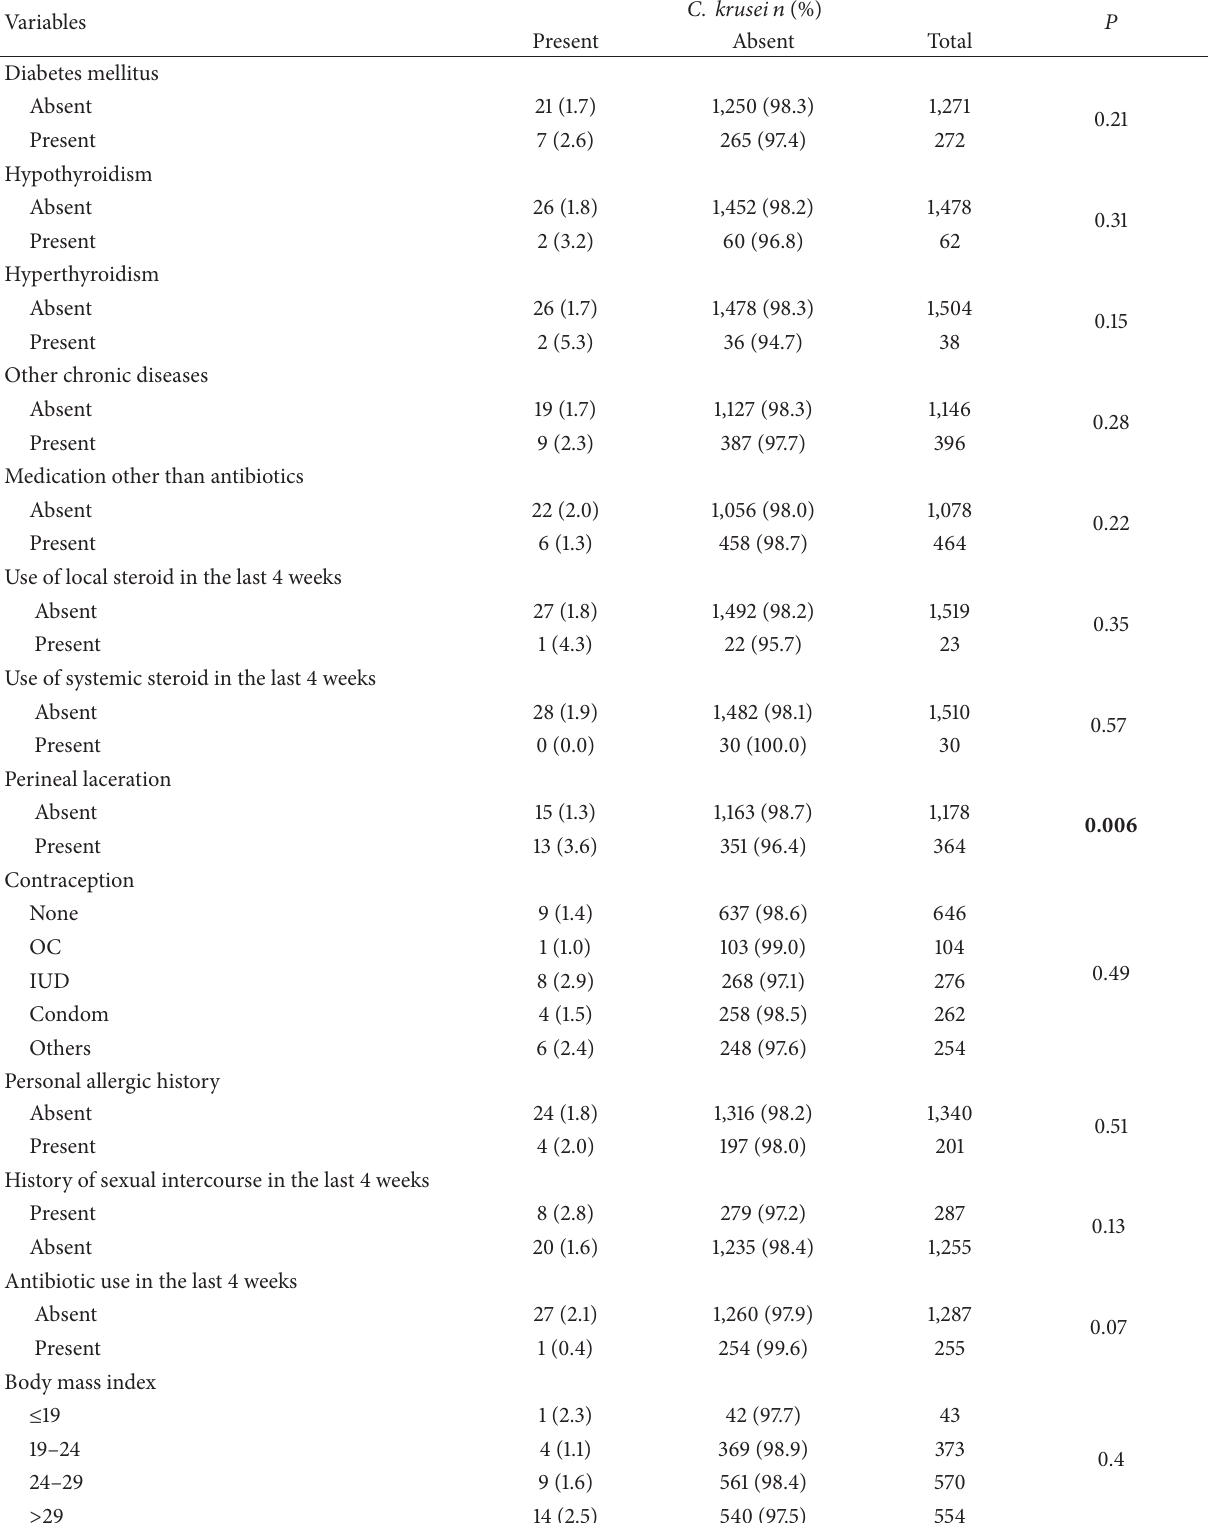
Table 2: Basic clinical characteristics of women with vaginal complaints in the